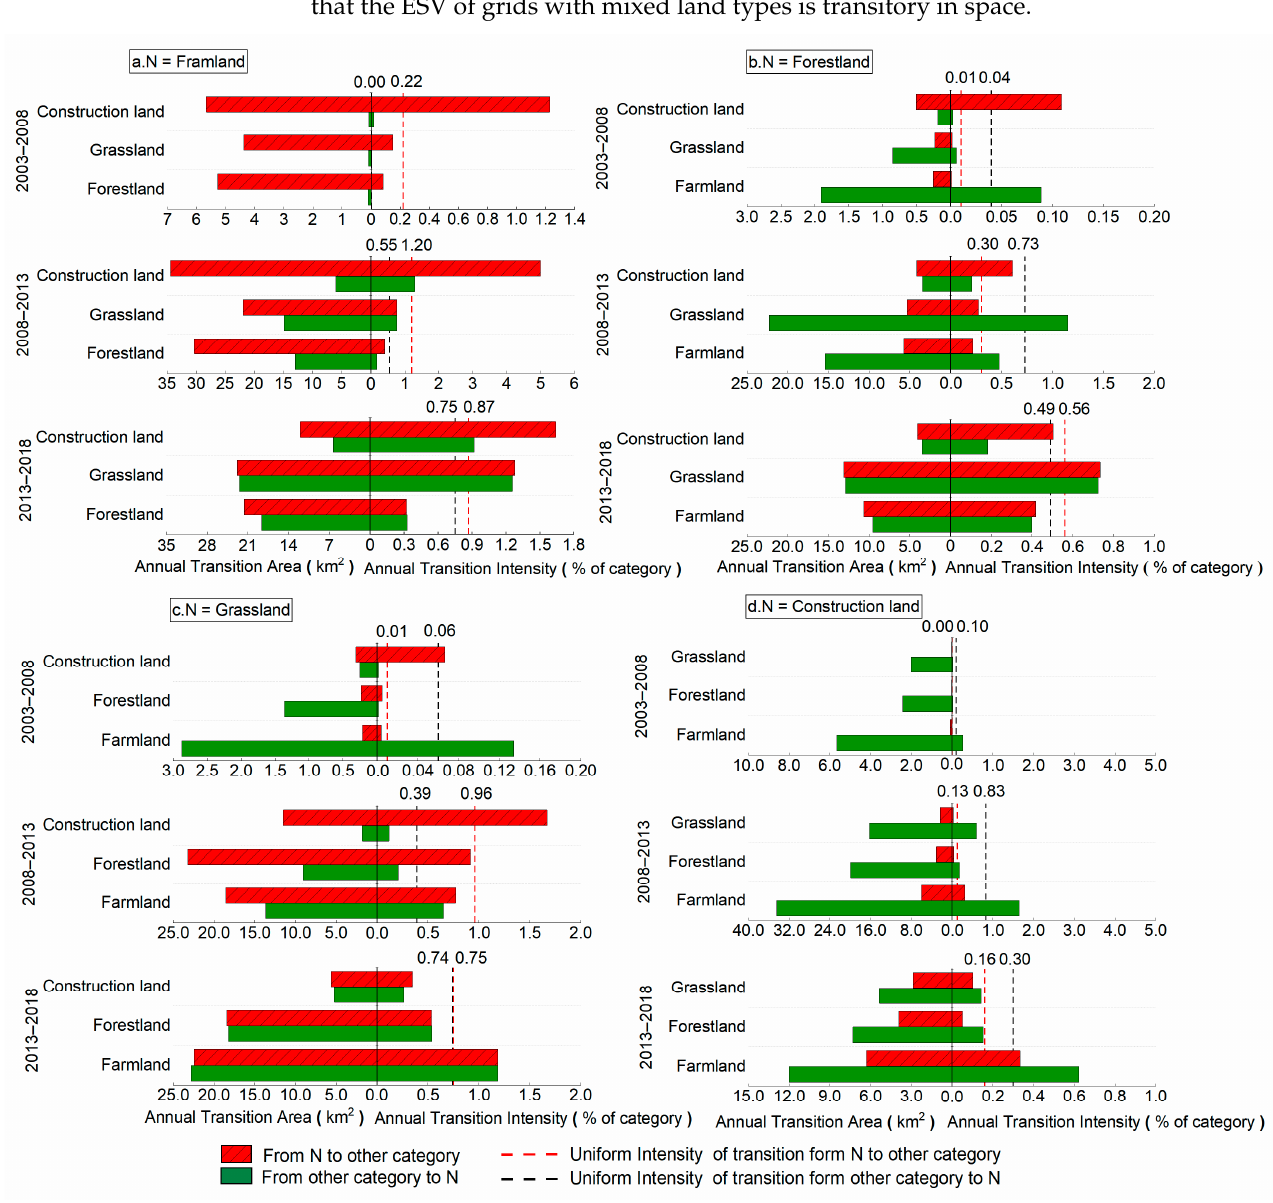
Figure 5. The transition level of land use reflected the directional magnitude among different